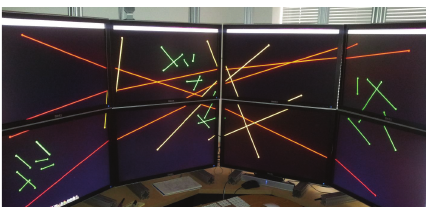
Figure 6: The LHRD used in the study. Red, yellow, and green lines demonstrate the concept of the LMH technique in terms of typical distances covered with each multiplier. H is used for large distances (red lines), M is used for medium distances (yellow lines), and L is for short distances (green lines).